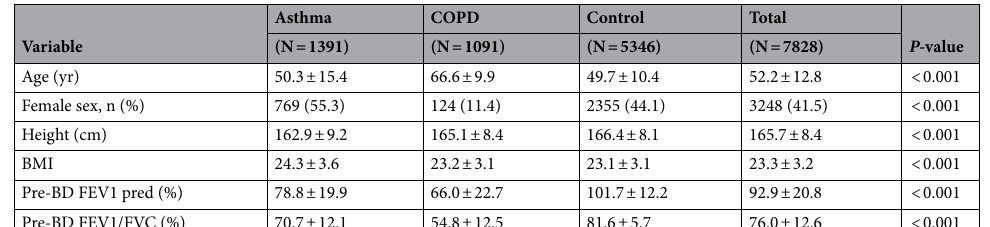
Table 1. Demographic characteristics of the discovery dataset. The mean ± SD values are shown for each cell. BMI, body mass index; FEV1, forced expiratory volume in 1 s; BD, bronchodilator; FVC, forced vital capacity. ANOVA and X 2 tests were performed for quantitative and qualitative variables, respectively.